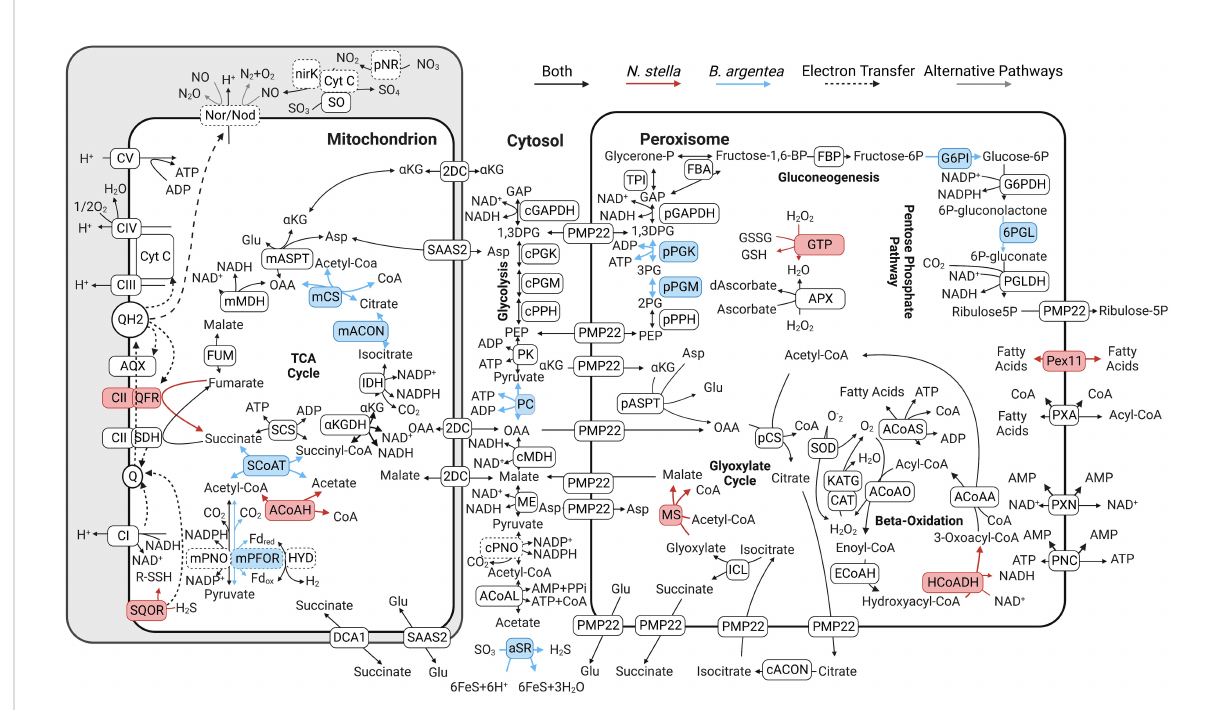
FIGURE 2 Pathway map of the predicted peroxisomal and mitochondrial metabolic processes in N. stella and B . argentea . Unique genes expressed in N. stella are shown with pink shade with the corresponding metabolic reactions indicated as red arrows. Unique genes expressed in B . argentea are shown with blue shade with the corresponding metabolic reactions indicated as blue arrows. Genes expressed in both species are shown in black boxes with the corresponding metabolic reactions indicated as black arrows. Biochemical conversions between metabolites are annotated with the abbreviation of corresponding genes, as de fi ned in SI Table S1. Boxes with a dotted outline indicate genes that have been described previously (Gomaa et al., 2021). Gray arrows represent alternative pathways for the same genes, speci fi cally with respect to the currently uncertain role of Nor/Nod (Gomaa et al., 2021). Q represents quinones/rhodoquinones and QH2 represents quinols/rhodoquinols. Cyt C represents Cytochrome (C) CI, CII, CIII, CIV, and CV, represent Complex I, II, III, IV, and V, respectively, of the electron transport chain. Dashed arrows indicate the fl ow of